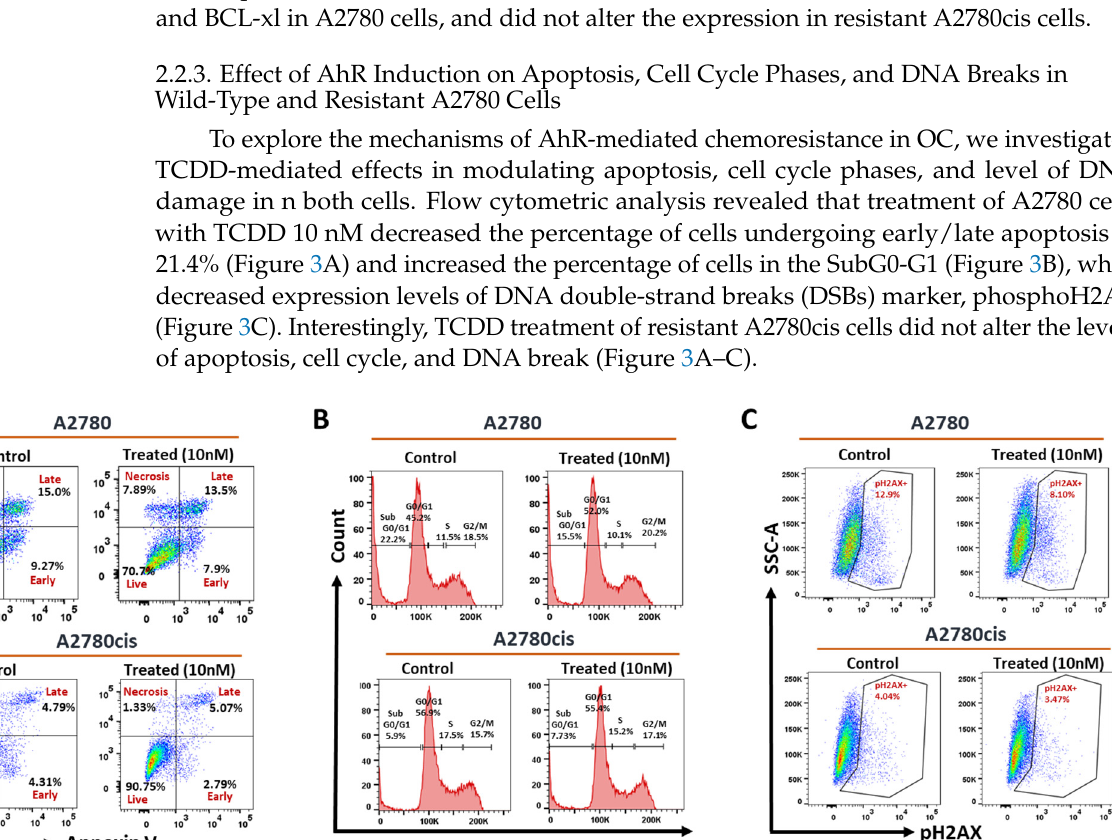
Figure 2. Effect of AhR activation on cell growth, cell survival, and AhR and BCL ‐ 2 family proteins in A2780 and A2780cis cell lines. A2780 and A2780cis cells were treated with wide concentrations of TCDD at different time intervals. ( A ) Cell growth was real ‐ time monitored for 120 h. ( B ) Cell survival was determined by colony formation assay analysis. Protein expression levels of ( C ) AhR, CYP1A1, CYP1B1, MCL − 1, BCL − 2, and BCL − xl proteins in response to 24 h TCDD treatment were determined by Western blot analysis. The protein panels are a composite of different blots and are representative blots for the indicated proteins and the loading control.